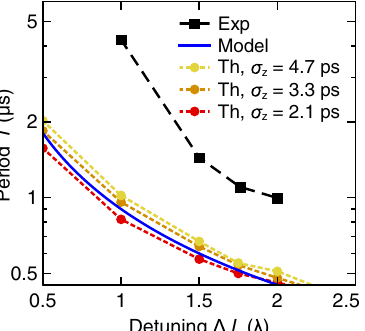
FIG. 7. Dependence of the LCO period T on the cavity detuning Δ L . The oscillation period is indicated in Fig. 5(a), experimental values are also extracted from the data shown in Fig. 6. The analytic model function is according to Eq. (2) and described in the text. Simulation results are obtained from 4D calculations based on Maxwell-Lorentz theory for different electron pulse durations σ z